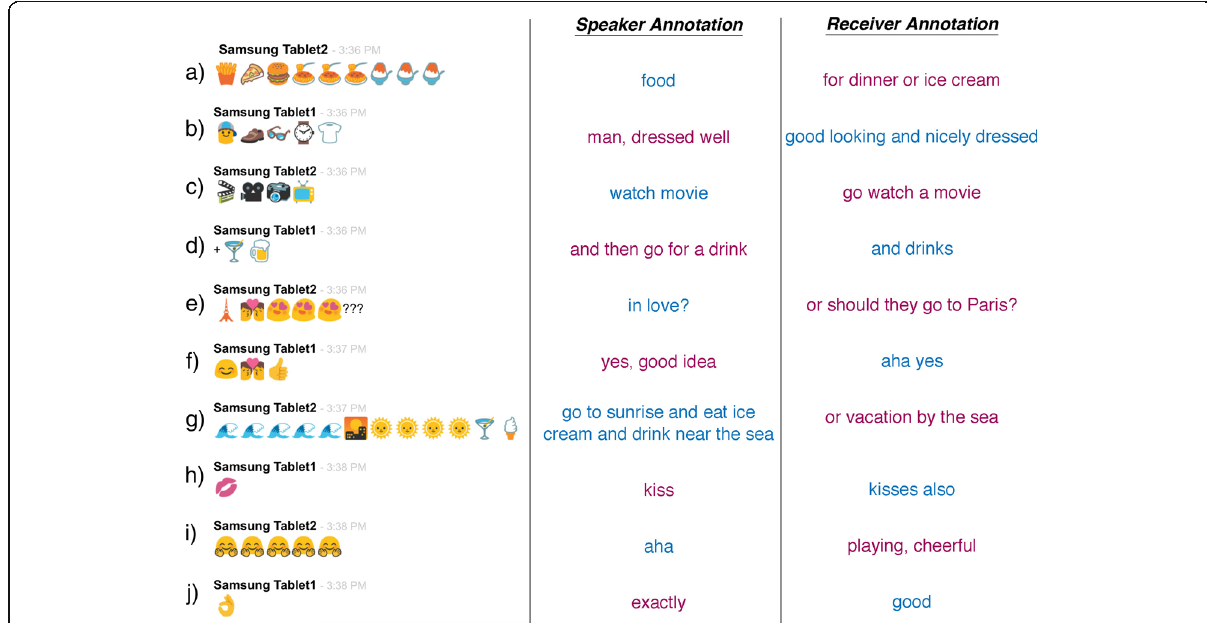
Fig. 3 An excerpt from an emoji-only conversation between two female participants with the prompt of ‘ What is a perfect date? ’ , along with post-experiment annotations given by the speaker and receiver of the messages. Note the prevalence of reduplication of emoji and